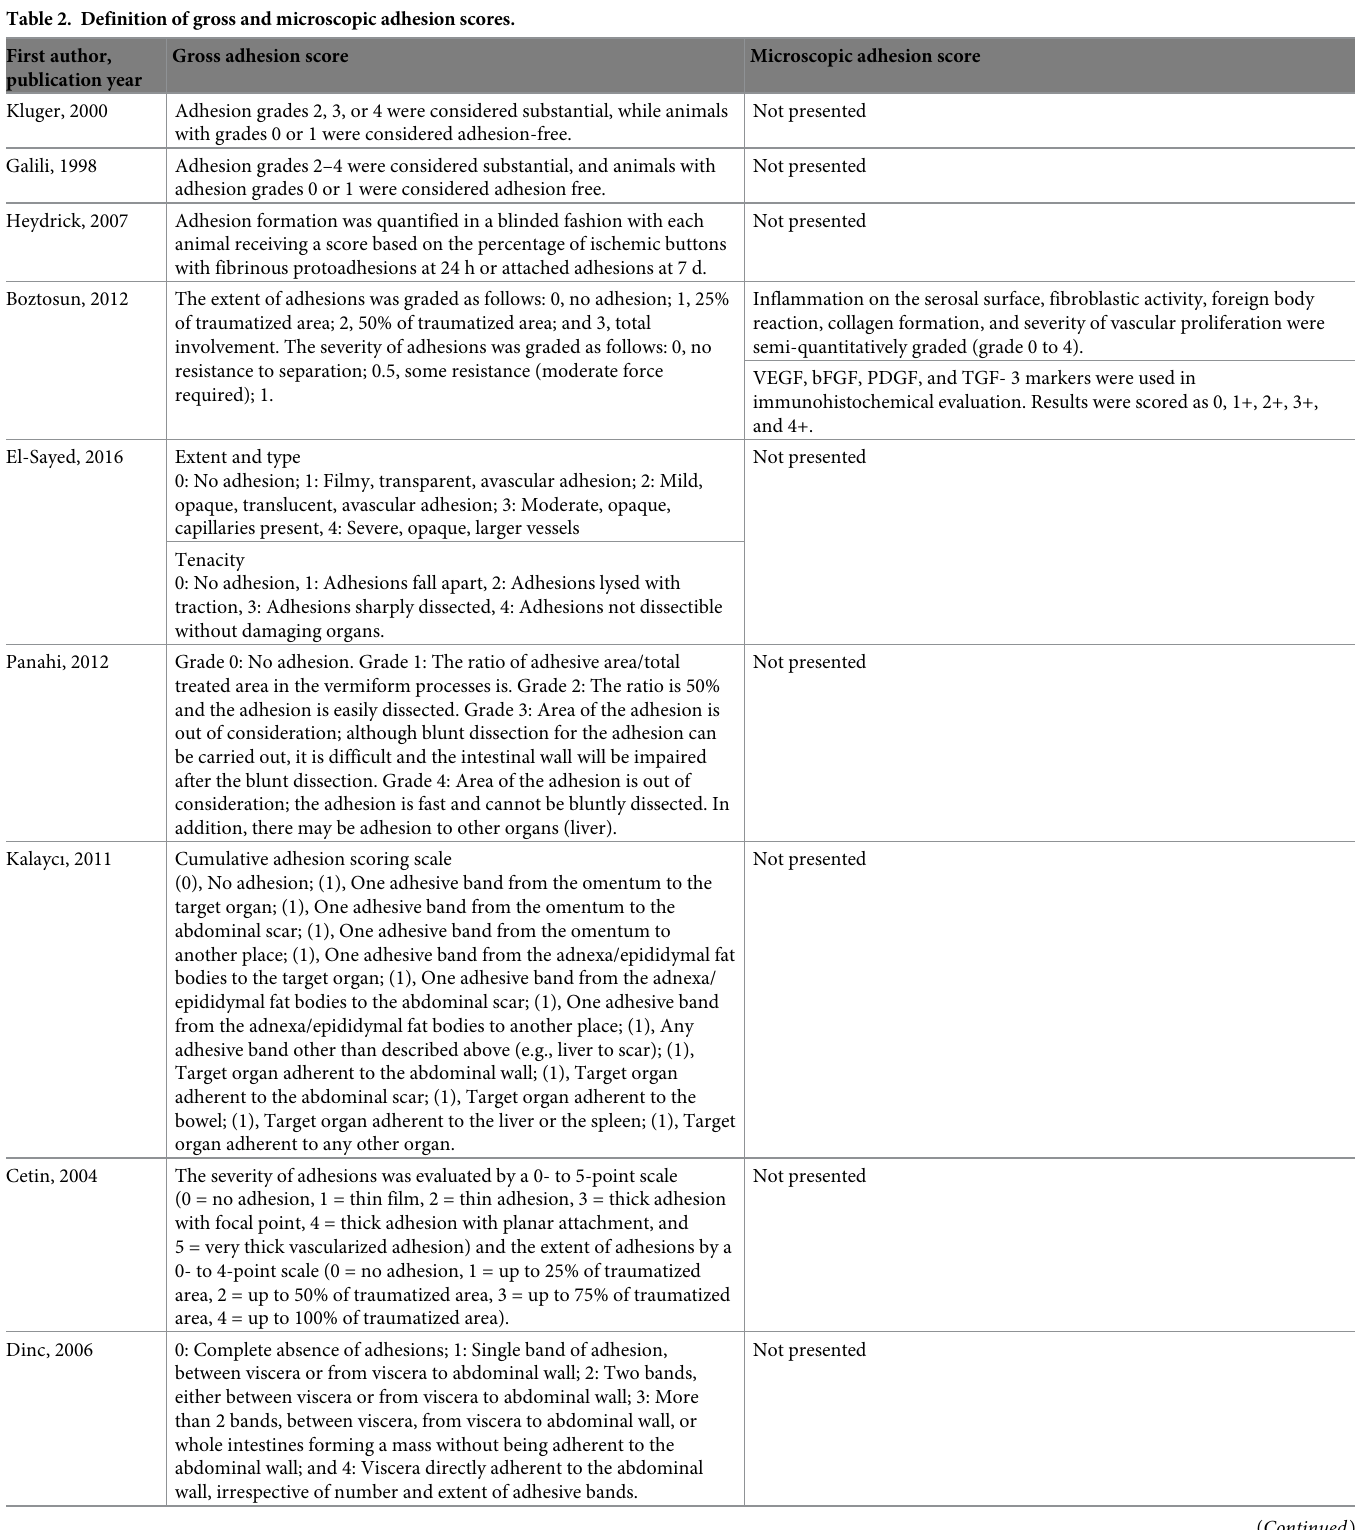
Table 2. Definition of gross and microscopic adhesion